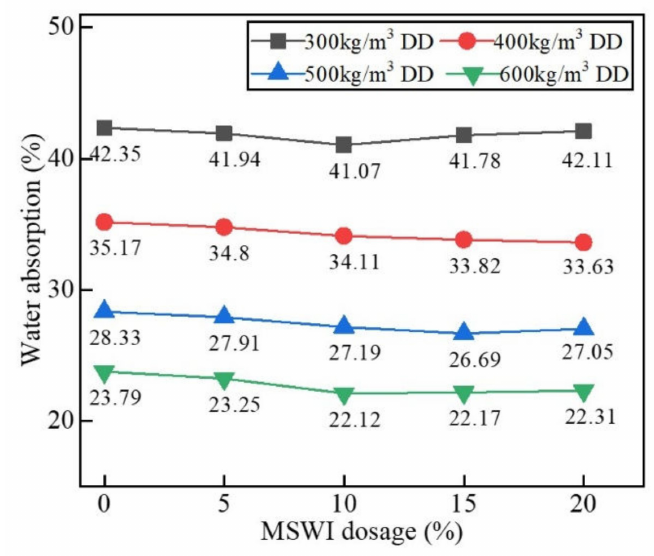
Figure 9. Water absorption rate of the recycled foamed concrete containing MSWI powder with different